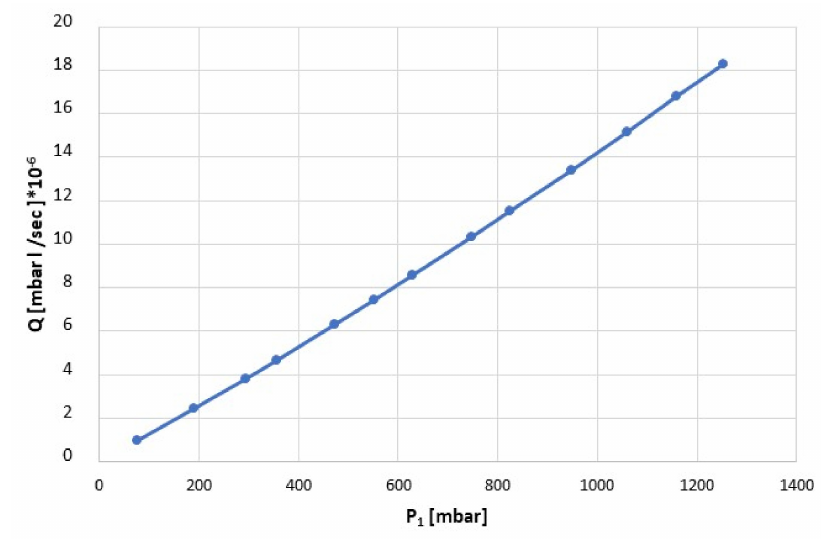
Figure 10. Flow measurement example of a membrane with 4